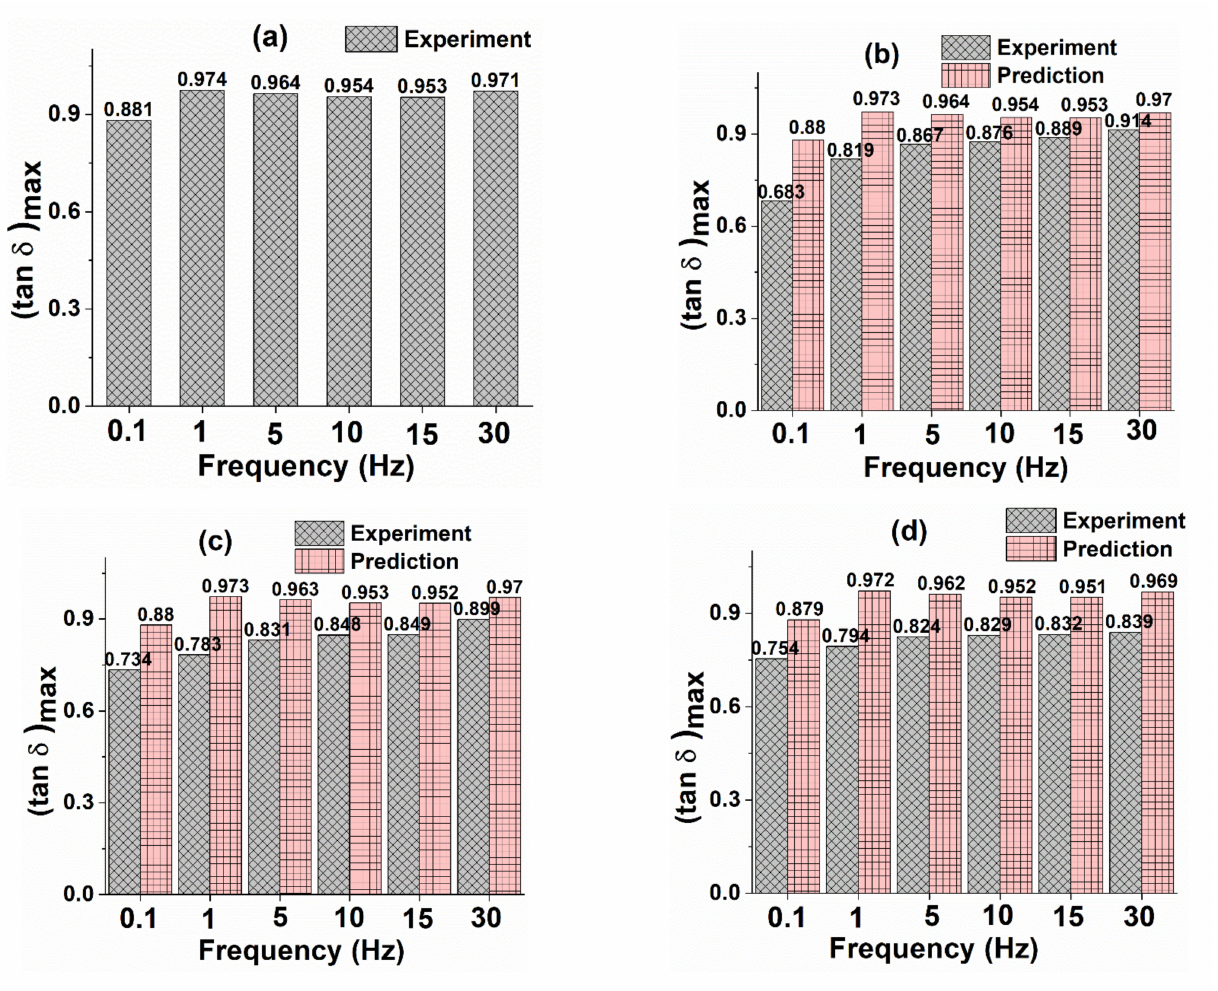
Figure 11. Loss factor of ( a ) pristine epoxy, ( b ) 0.05 wt%, ( c ) 0.1 wt%, and ( d ) 0.2 wt% GO